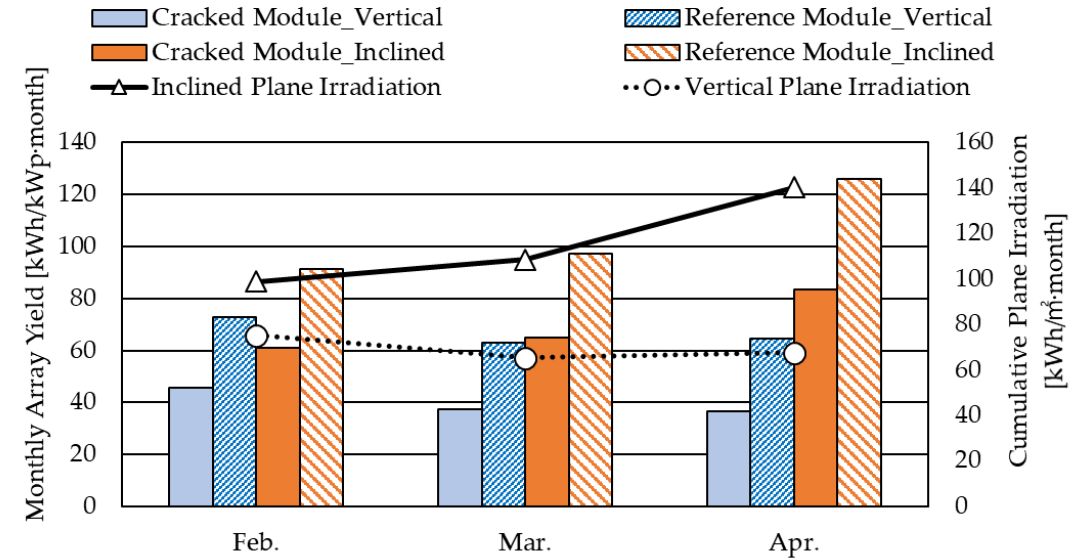
Figure 8. Comparison of power yields and plane irradiances between reference and cracked modules.